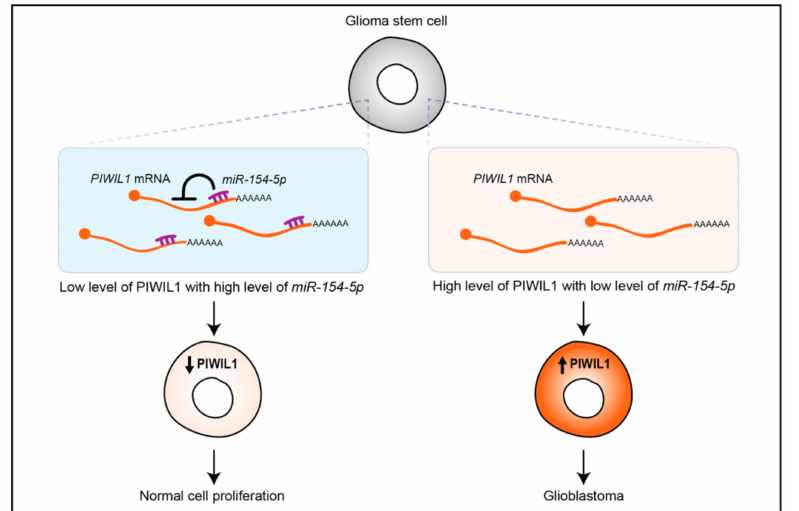
Figure 1. An axis of the miRNA and PIWI pathway in malignant glioblastoma. PIWIL1 is ex- pressed at higher levels in glioma stem cells compared to non-glioma stem cells and localized in the cytoplasm [35]. Downregulated PIWIL1 by miRNA-154-5p (miR-154-5p) inhibits malignant behavior of glioblastoma, while upregulated PIWIL1 in the lack of miR-154-5p leads to malignant glioblastoma